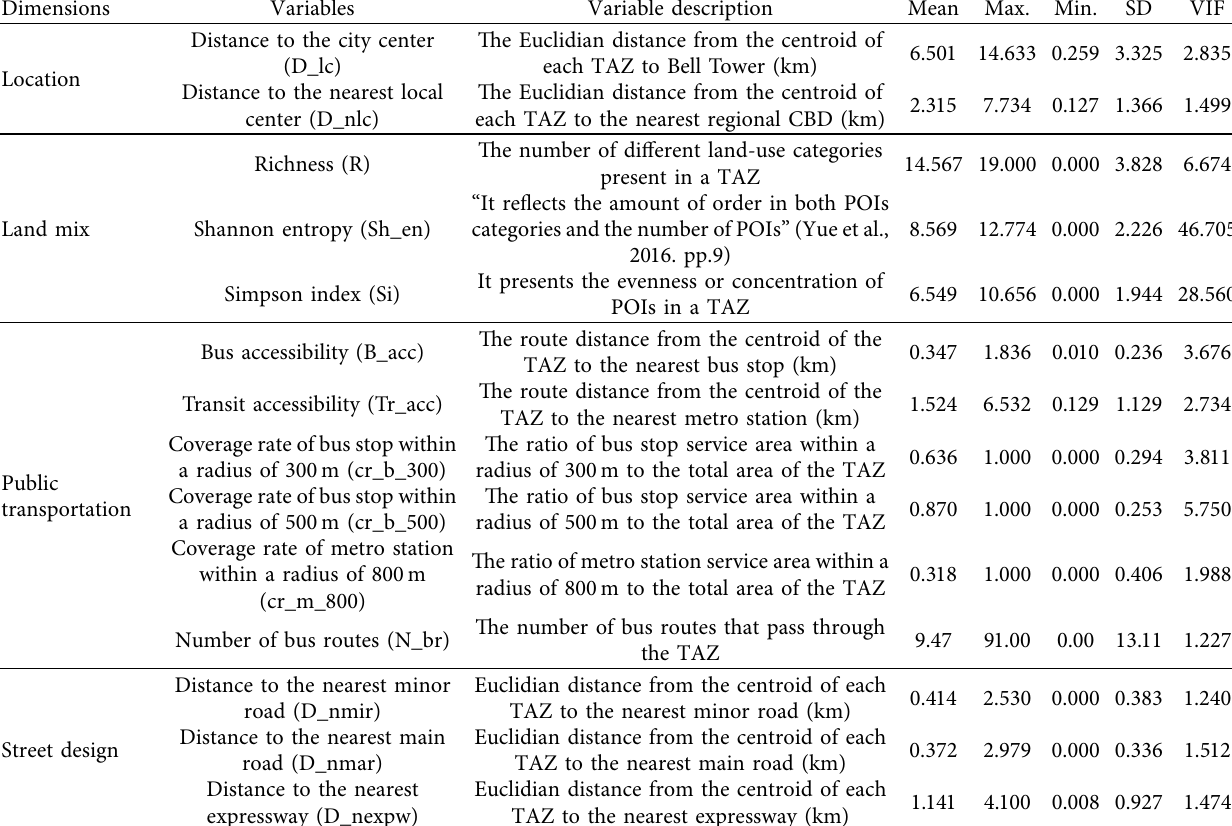
Table 2: Variable description and descriptive statistics of built environment.